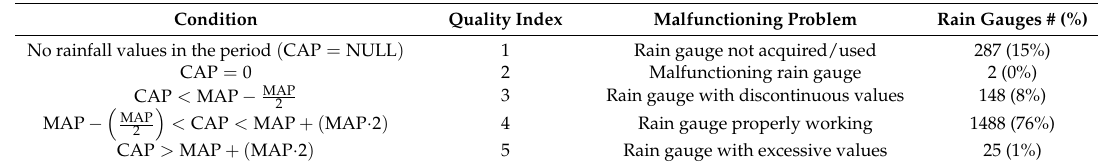
Table 3. Criteria for the estimation of rain gauge reliability.